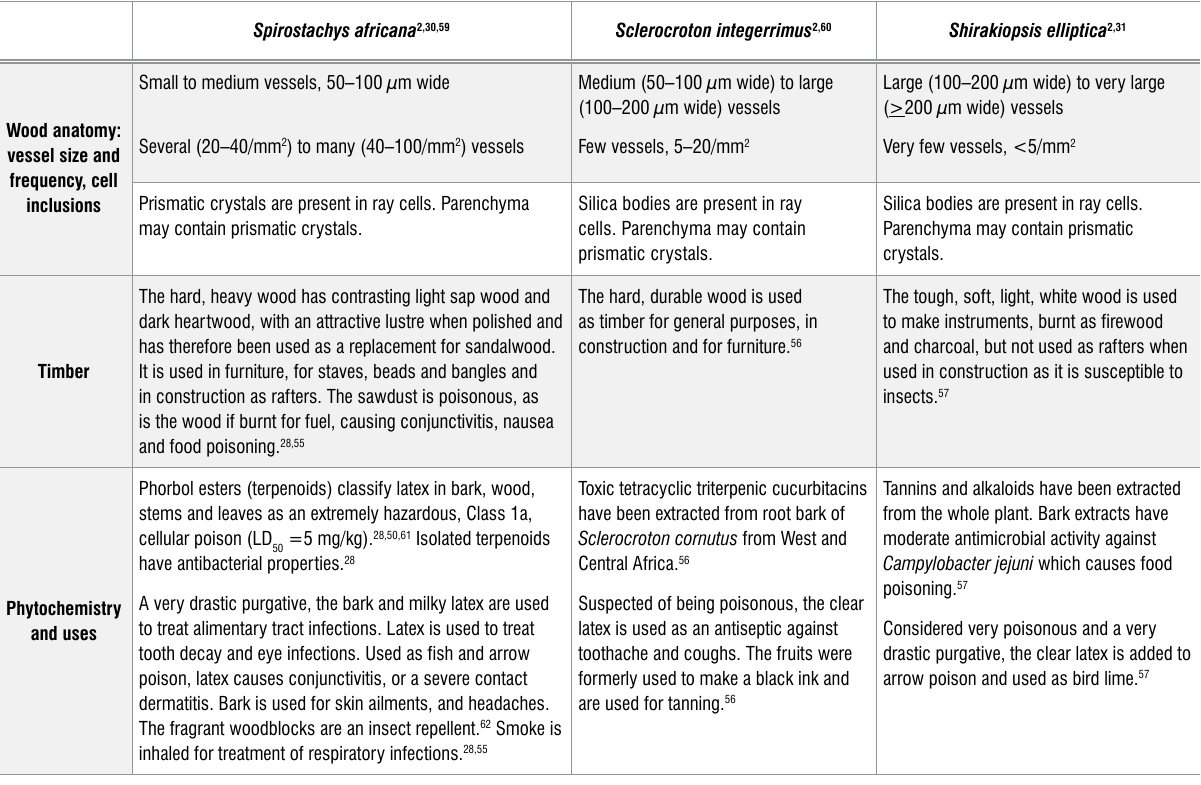
Comparing the wood anatomy, environment and uses of Spirostachys, Sclerocroton and Shirakiopsis (Euphorbiaceae) Spirostachys africana 2,30,59 Sclerocroton integerrimus 2,60 Shirakiopsis elliptica